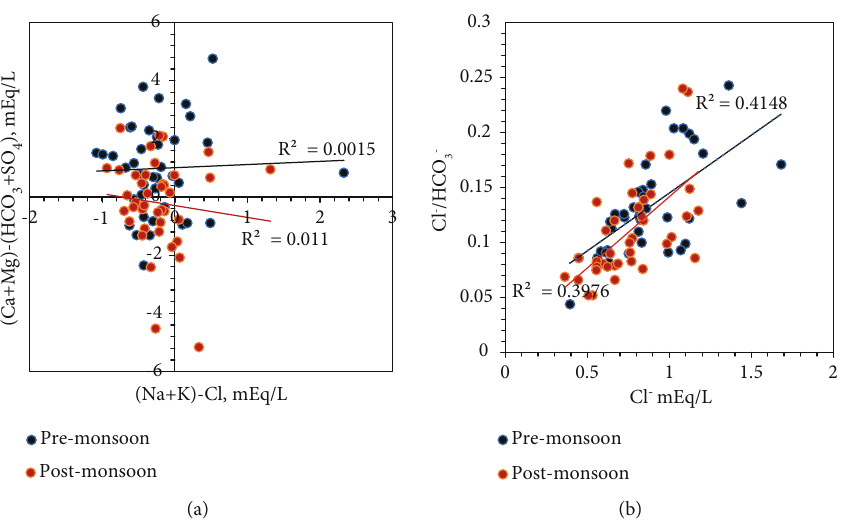
− + SO 42 − ) to indicate the cation exchange reactions: (b) Figure 11: (a) Bivariate plot of ( Na + + K + )-Cl - versus ( Ca 2+ + Mg 2+ )-( HCO 3 bivariate plot of Cl - /HCO 3- versus Cl - to fi nd the saltwater Table 6: Statistical summary of saturation indices (SIs) of minerals in groundwater samples using PHREEQC-3v program. Premonsoon (PRM) Postmonsoon (POM) Anhyd. Arago. Calcite Dolom. Gyp. Halite log p CO Anhyd. Arag. Calcite Dolom. Gyp. Halite log p CO 2